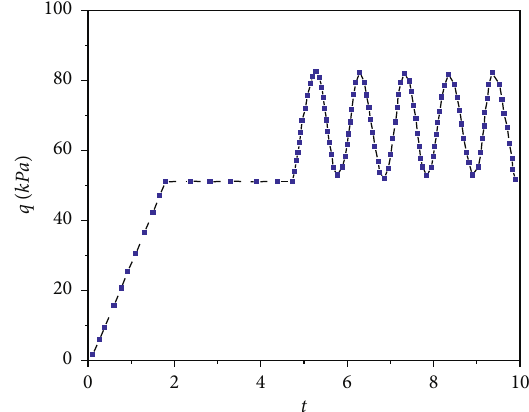
Figure 15: Vertical stress time history